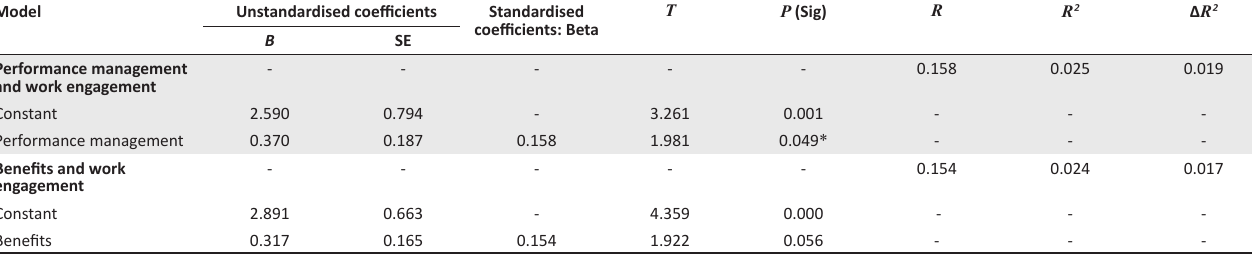
TABLE 5: Regression analyses of rewards and work engagement.